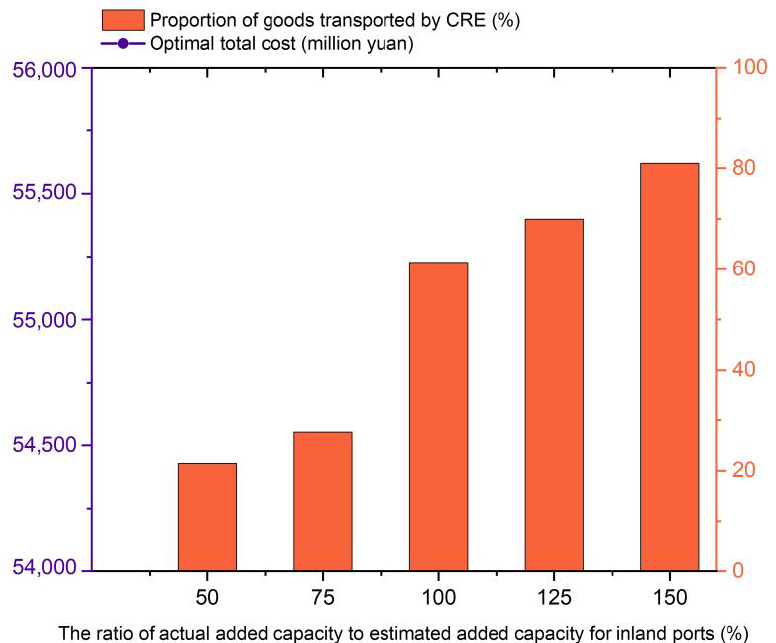
Figure 6. Changes in the proportion of CRE and total optimal costs when actual added capacity